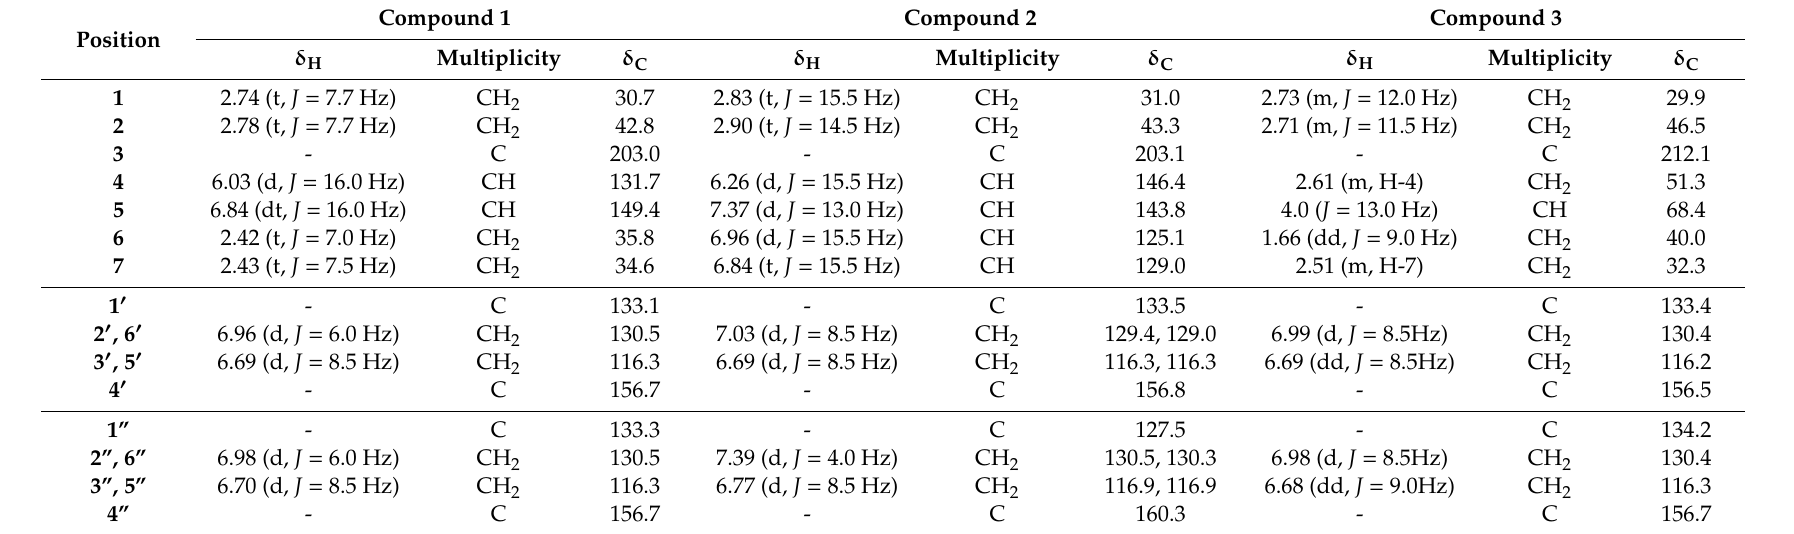
Table 1. NMR data of three diarylheptanoids from Alnus